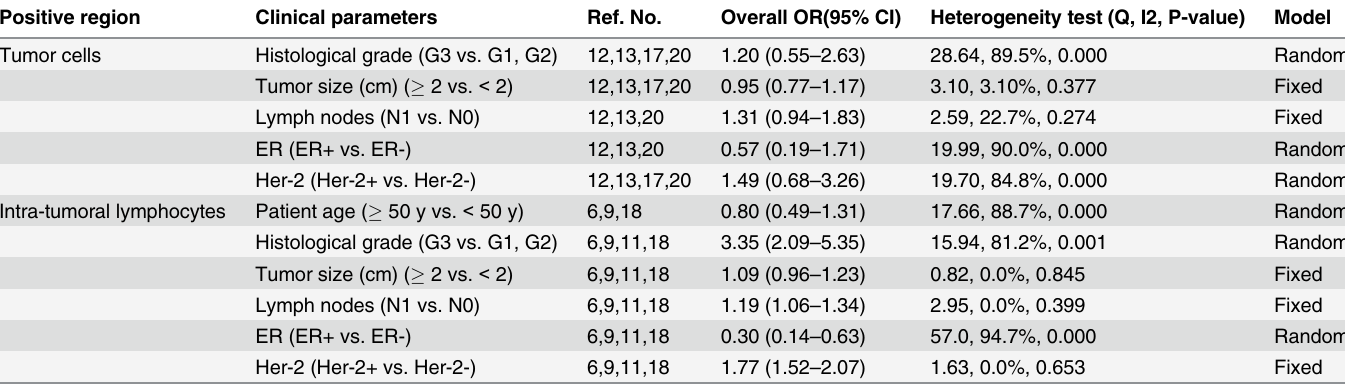
Table 3. Main results for the meta-analysis between FOXP3 expression and clinicopathological parameters. Positive